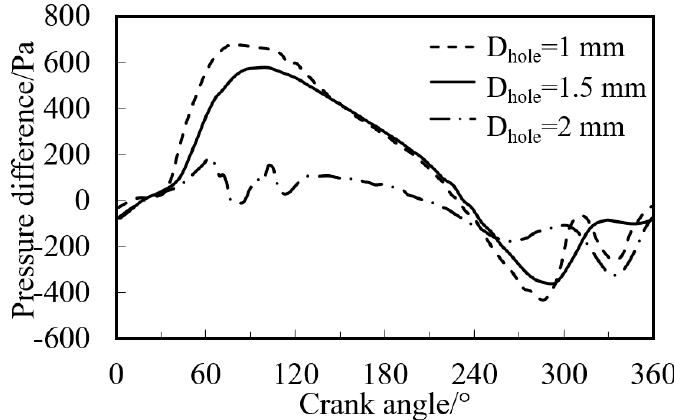
Figure 12. Variations of pressure difference with the crank angle.